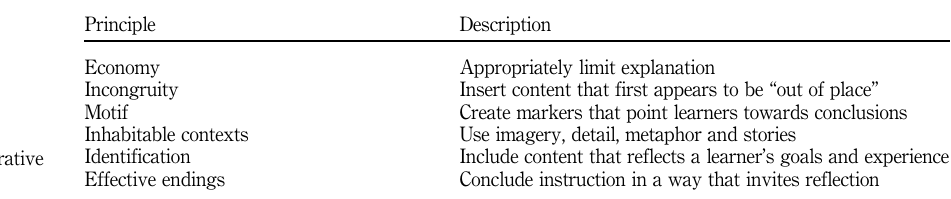
designing narrative